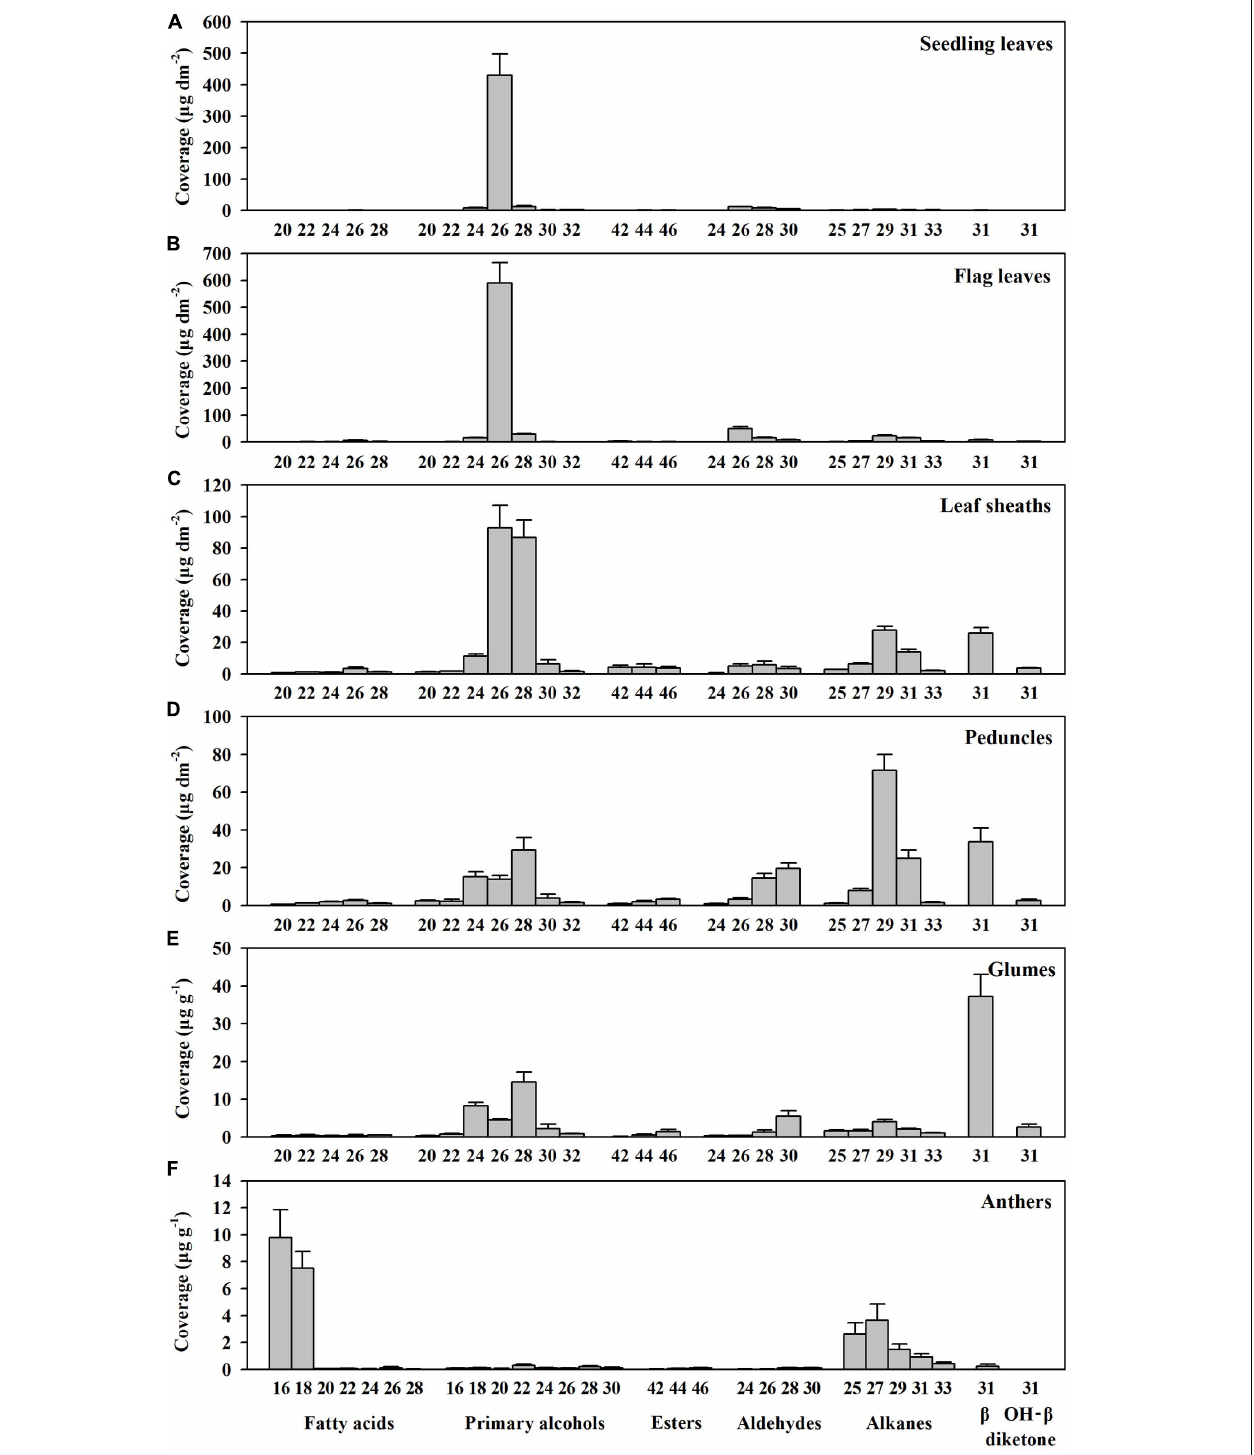
FIGURE 1 | Chain length distributions within compound classes of cuticular wax from various organs of Aegilops tauschii . Cuticular wax mixtures were extracted from (A) seedling leaves, (B) flag leaves, (C) leaf sheaths, (D) peduncles, (E) glumes, and (F) anthers of Ae. tauschii . The coverage of individual compound is expressed as µ g per unit dm 2 (seedling leaves, flag leaves, leaf sheaths, and peduncles) and µ g per unit g fresh weight (glumes and anthers). Values are means of three biological replicates. Error bars = SD.